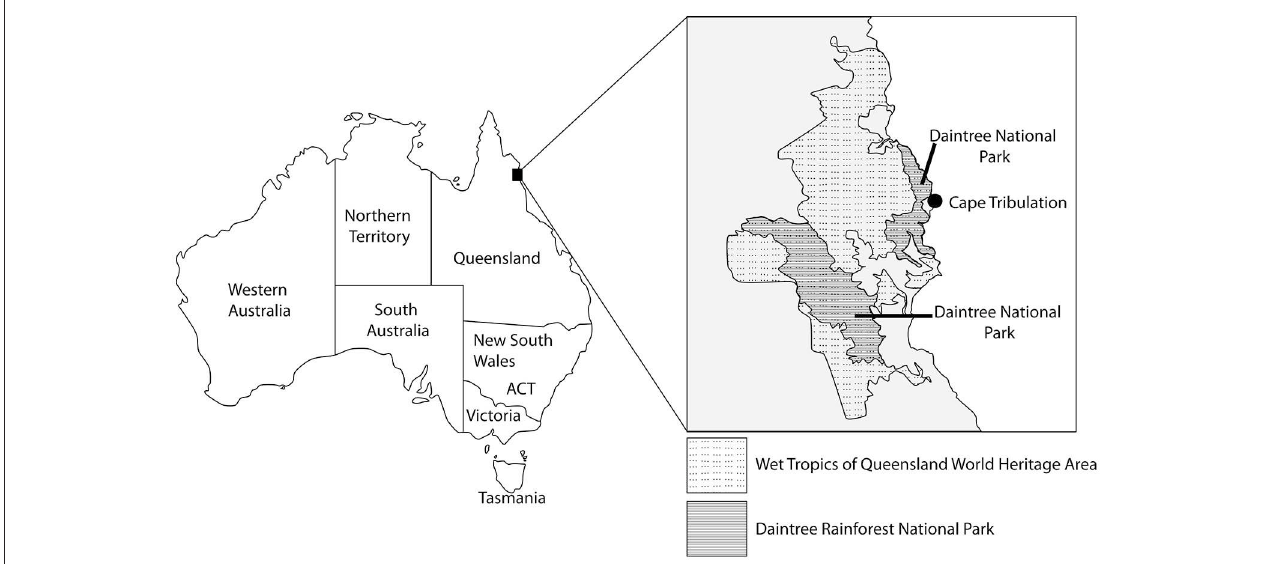
FIGURE 1 | Field site location: Daintree Rainforest National Park at Cape Tribulation, Queensland,